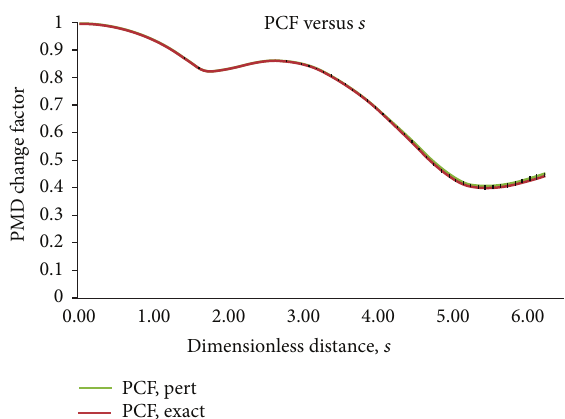
Figure 3: The PCF curve for a perturbative limit with Λ = 1 and 𝐿 𝐵 = 5 .